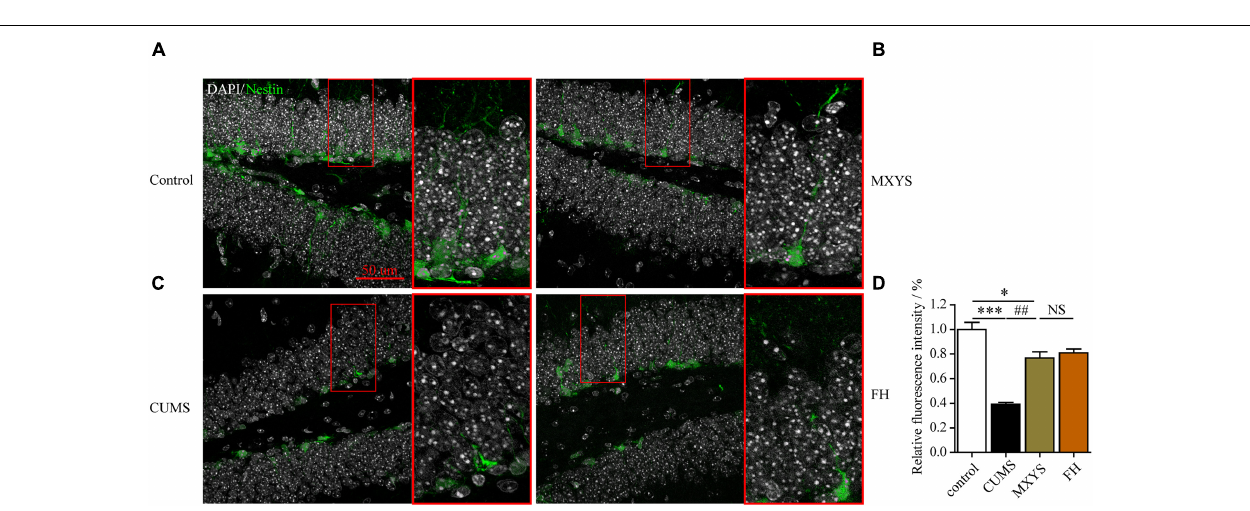
FIGURE 4 | MXYS supported the Nestin-positive neurons survival in the hippocampus against the CUMS treatment. Representative micrographs of IF staining for the Nestin-positive neurons (green, scale bar = 50 µ m, 400 × magnification) in the hippocampal DG region of 4 groups ( A , Control group; B , MXYS treatment group; C , CUMS group; D , FH treatment group). Compared with the control group, the CUMS-exposed mice displayed lower Nestin expression in the hippocampus, which were improved by the MXYS and FH administration. Data are presented as means ± SEM. ∗ P < 0.05, ∗∗∗ P < 0.001 versus control group; ## P < 0.01 versus CUMS group; NS, P >